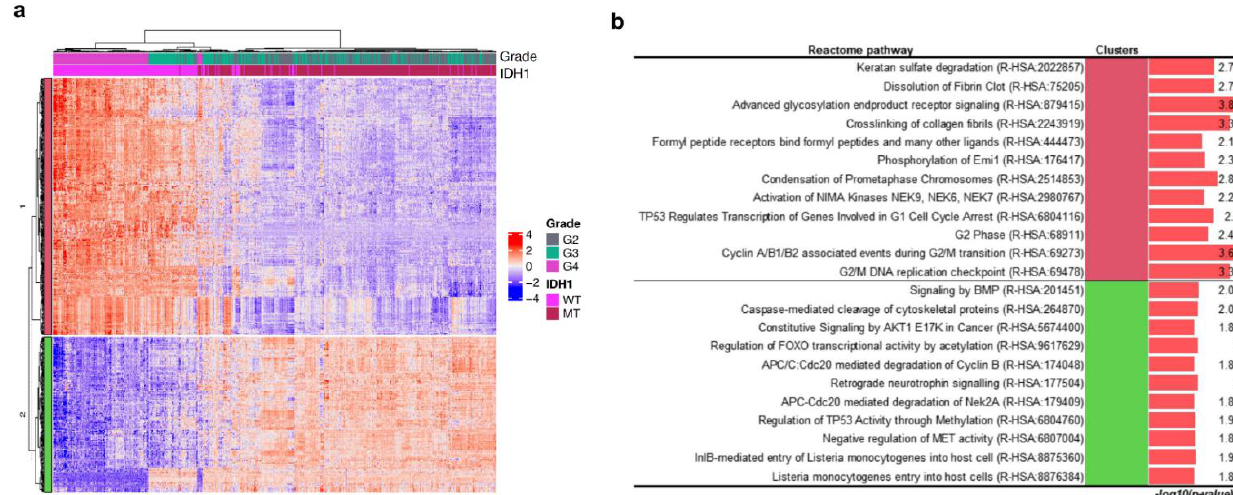
Figure 3. Heatmap with hierarchical tree of patients by gene expression pattern with information gain (IG) over 0.35. The top annotations show tumour grade and mutation status ( IDH1 mutant or wild-type). WT indicates wild-type; MT indicates mutation ( a ). Statistically significant results of the pathway enrichment analysis of gene clusters in the IDH1 hierarchical group ( b ).